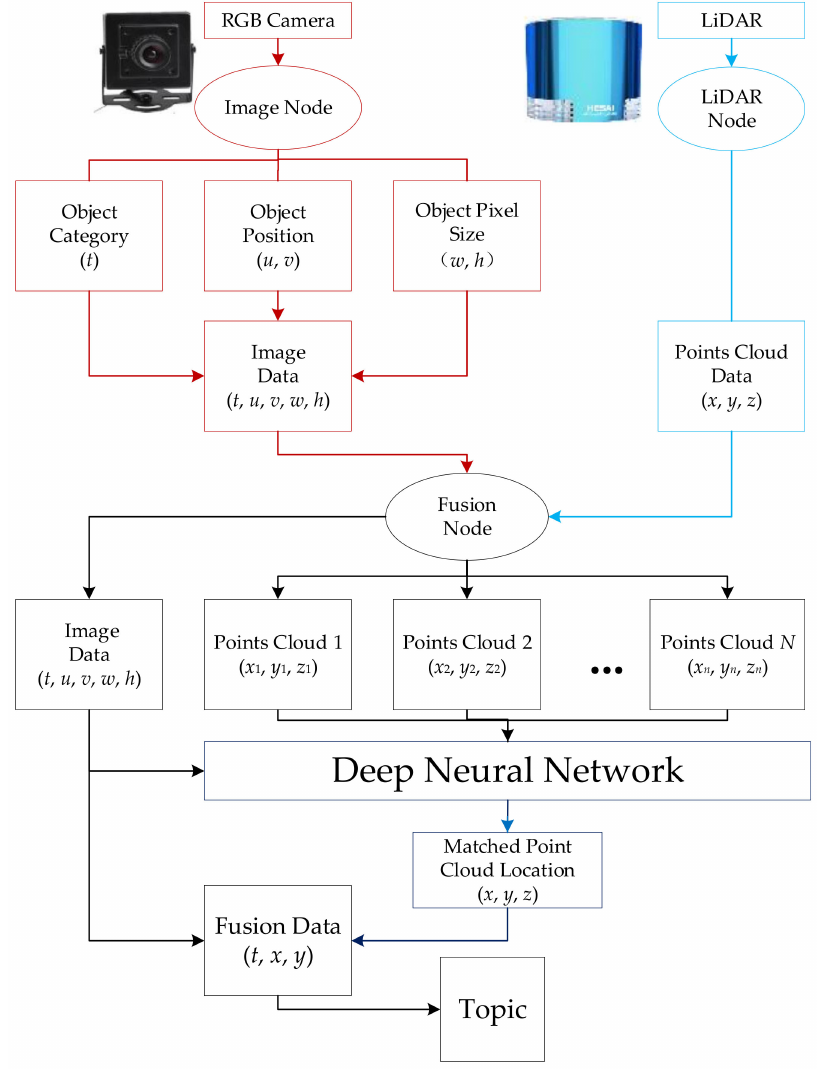
Figure 3. Flowchart of data fusion.